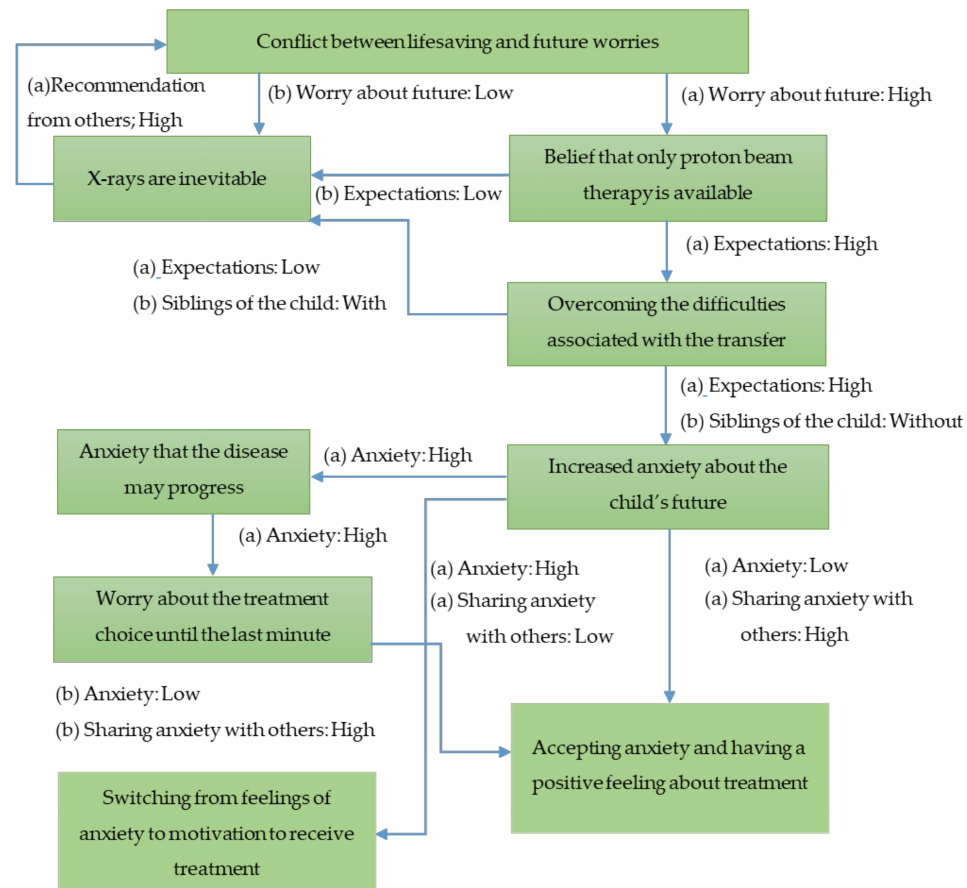
Figure 1. Process of mothers’ feelings about proton beam therapy. Boxes indicate the category. Arrows represent the processes between the categories. Phrase(s) next to arrow: the dimension experienced in the